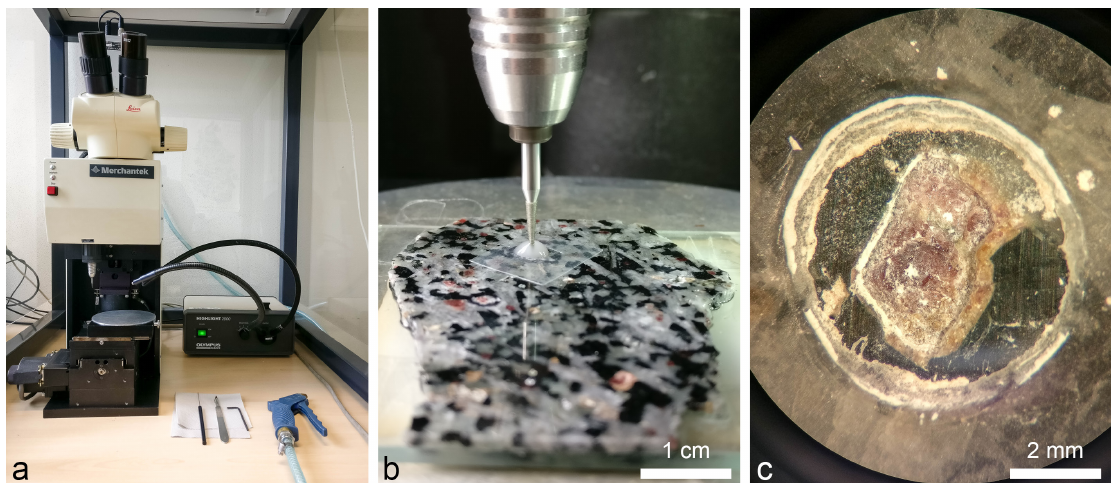
Figure 2. Materials, procedure and result of the drilling procedure. ( a ) the micro-mill setup in the laminar flowhood; ( b ) drilling eudialyte from a test sample using a drop of Milli-Q water to capture the milled material; ( c ) result after the first drilling